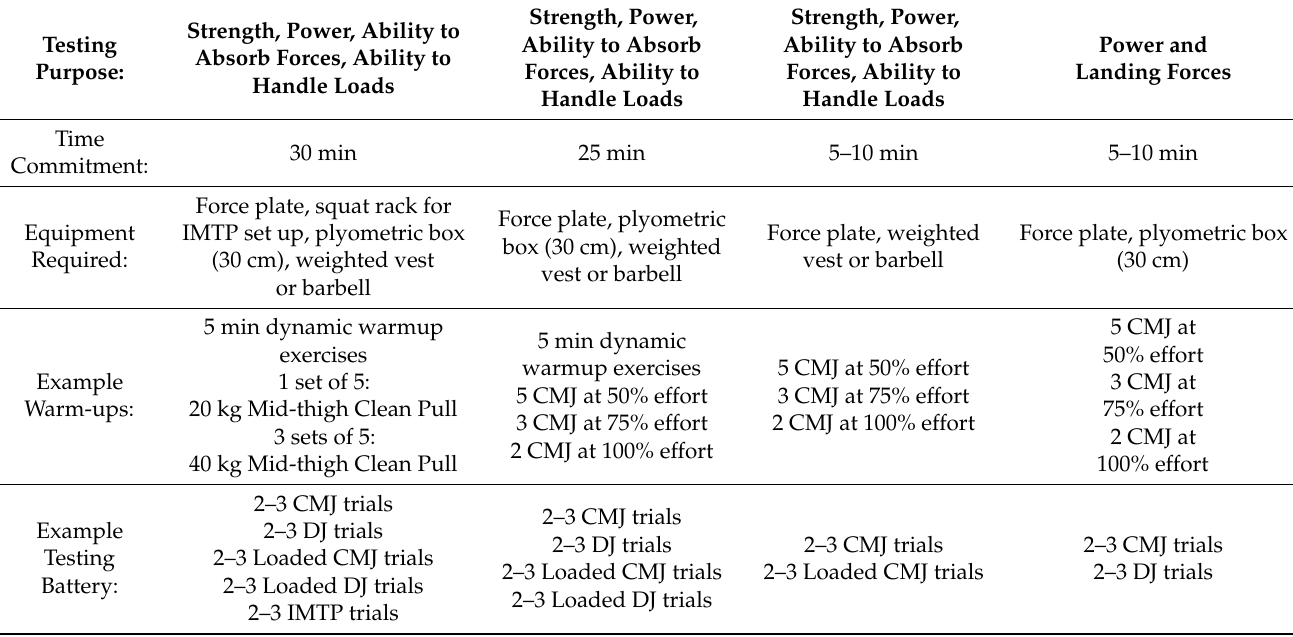
Table 1. Sample warm-up protocols and testing